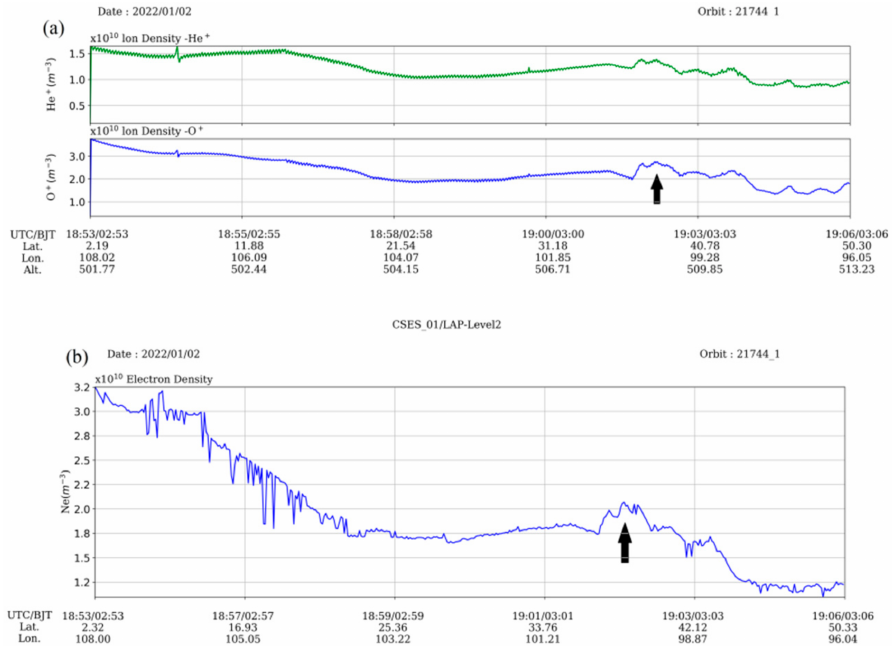
Figure 11. Fluctuations in ( a ) He + and O + densities and ( b ) electron density registered by the CSES satellite on 2 January 2022, 6 days before the Menyuan M S 6.9 EQ. Obvious variations related to this Menyuan event are labeled with black